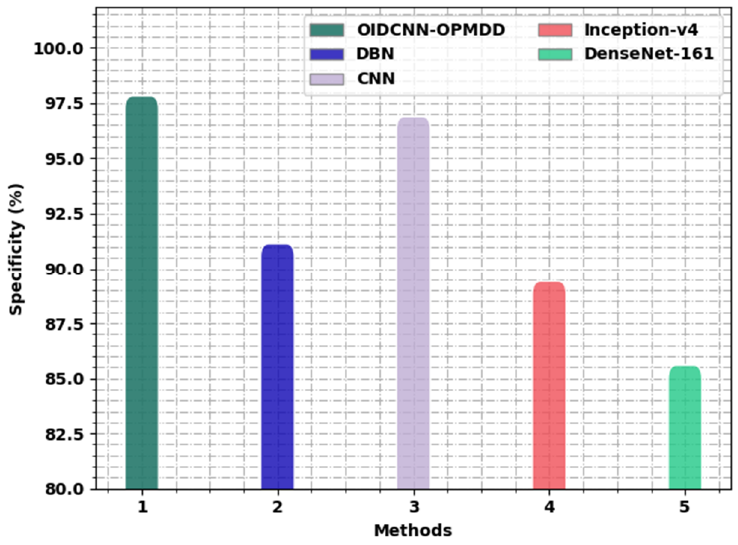
Figure 14. Spec y analysis of OIDCNN-OPMDD approach with existing Figure 14. Spec_y analysis of OIDCNN-OPMDD approach with existing algorithms.